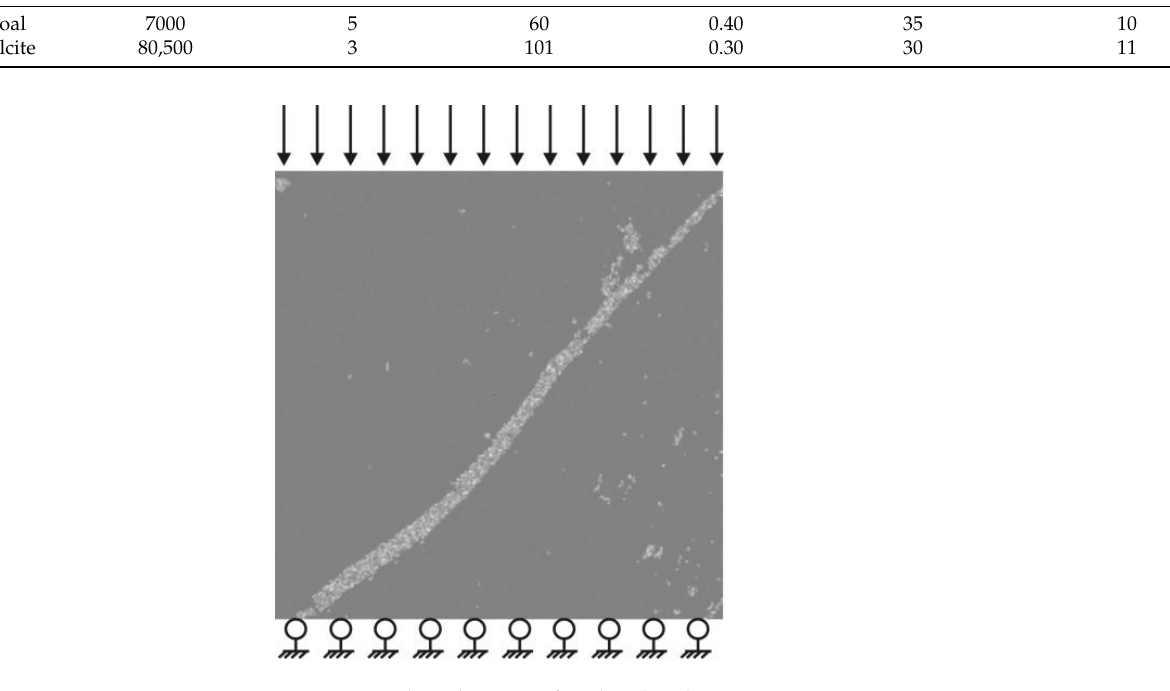
Figure 2. Loading diagram of coal and rock.